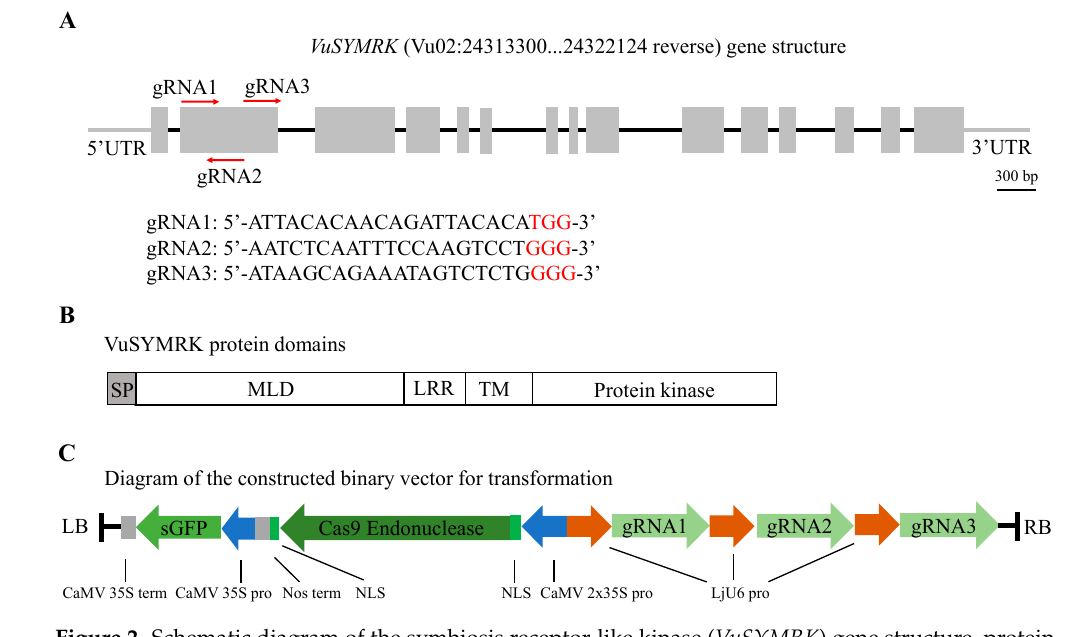
Figure 2. Schematic diagram of the symbiosis receptor-like kinase ( VuSYMRK ) gene structure, protein domains and the CRISPR-associated protein 9 (Cas9) / guide RNA (gRNA) binary vector. ( A ) Diagram of the VuSYMRK gene structure. The VuSYMRK gene is located on the reverse strand of chromosome 2 from 24313300 to 24322124. Grey line, untranslated region (UTR); black line, introns; grey box, exons; red arrows, gRNA target sites. The PAM sequences are in red font. ( B ) Diagram of predicted protein domains. SP, signal peptide; MLD, malectin-like domain; LRR, leucine-rich repeat; TM, transmembrane domain. ( C ) Illustration of the constructed binary vector for the CRISPR-Cas9 system. RB and LB, right and left borders; CaMV 35S pro, Cauliflower mosaic virus (CaMV) 35S promoter; CaMV 2X35S pro, CaMV 2X35S promoter; CaMV 35S term, CaMV 35S terminator; Nos term, nopaline synthase gene (Nos) terminator; NLS, nuclear localization sequence; LjU6 pro, L. japonicus U6 promoter.